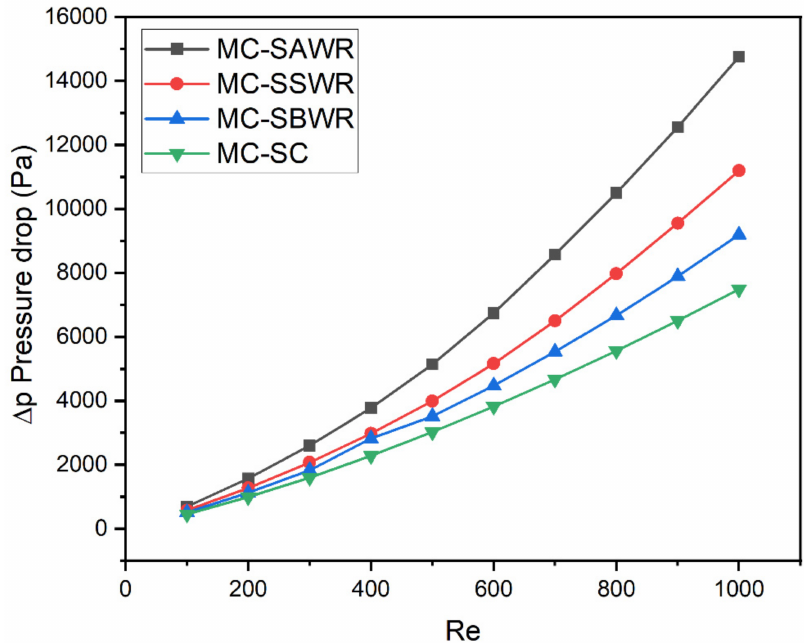
Figure 12. Variation of pressure drop ( ∆ p ) with Re for different MCHS